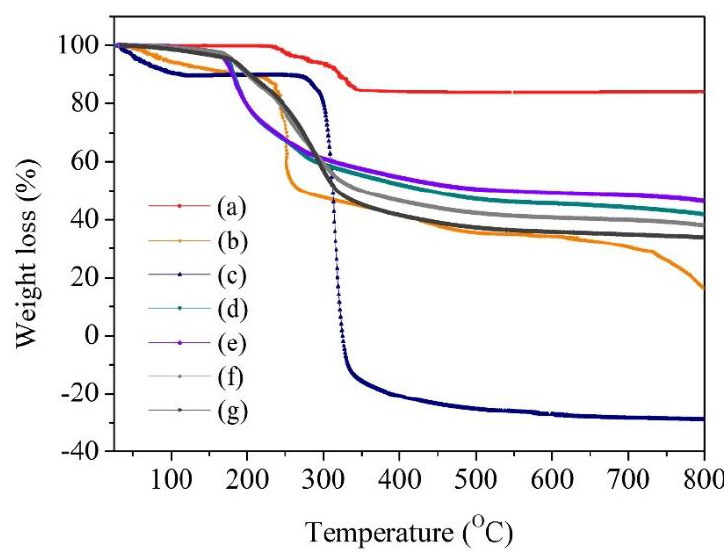
Figure 5. TGA curves of ( a ) KH 2 PO 4 , ( b ) alginate, ( c ) starch, ( d ) PHBs-DI, ( e ) PHBs-pH = 5, ( f ) s- PHBs-DI, and ( g ) s-PHBs-pH = 5.